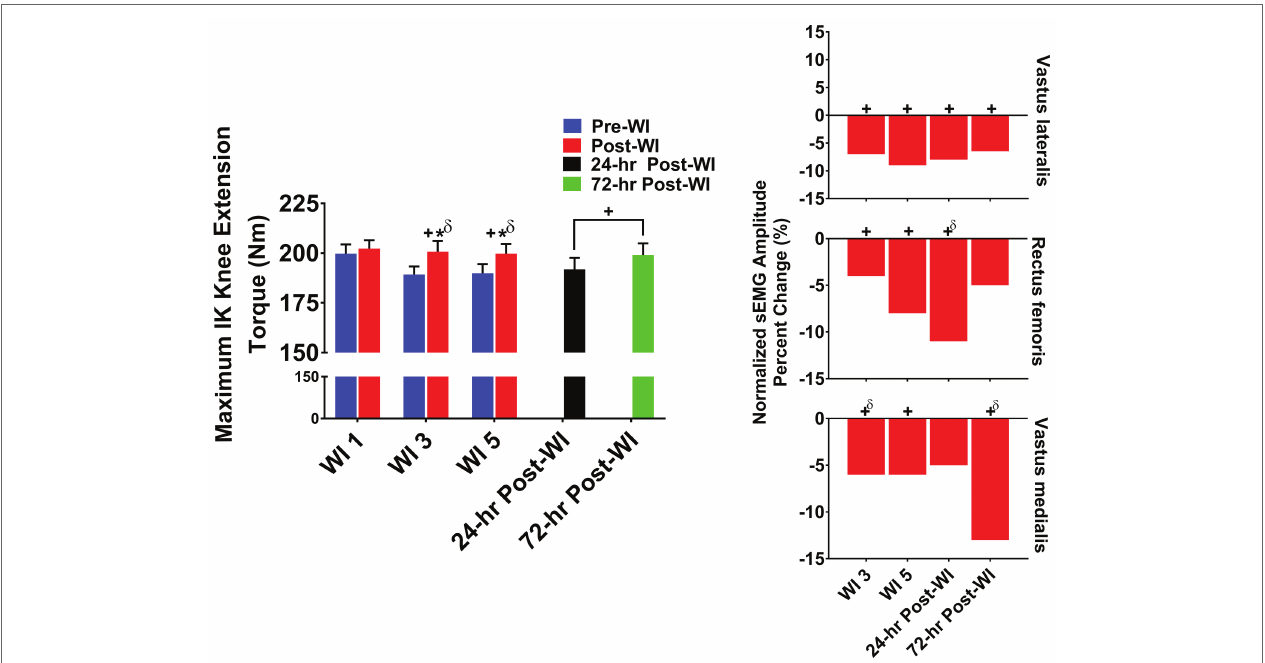
FIGURE 4 | Maximum IK knee extension results. Across subject ( n = 13) mean ± SEM is shown. Left graph – performance (torque): post-WI performance was greater than pre-WI on WIs 3 and 5. Overall performance declined on WIs 3 and 5 when compared to WI 1. “*” denotes pre/post-WI main effect ( p < 0.05). “+” only denotes time main effect ( p < 0.05). Main effect symbol with “ δ ” denotes ( p < 0.001). Right graph – normalized sEMG day percent change: neuromuscular activation was significantly lower throughout the dive week and recovery period when compared to WI 1 for all three knee extensors. “+” denotes time main effect ( p < 0.05). Main effect symbol with “ δ ” denotes ( p <